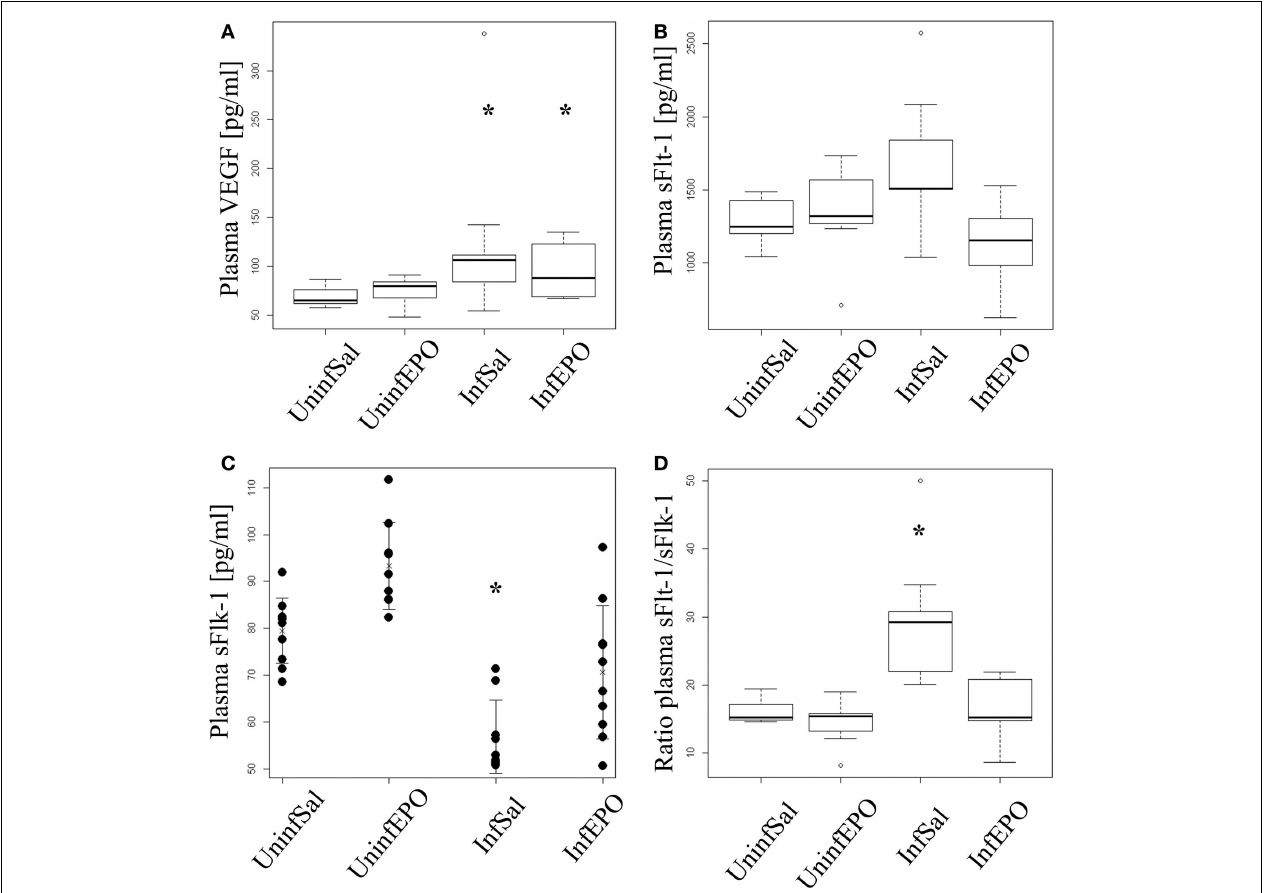
receptor in both infected ( p = 0.03) and uninfected mice ( p = 0.02) compared with the corresponding saline-treated control groups.Yet, infection strongly decreased sFlk-1 levels in EPO-treated mice ( p < 0.001) compared with UninfEPO mice. (D) When taking the ratio of sFlt-1 to sFlk-1 only InfSal was significantly different from uninfected mice ( p <0.002). Box plots (A,B,D) show median values and interquartile ranges.Whiskers